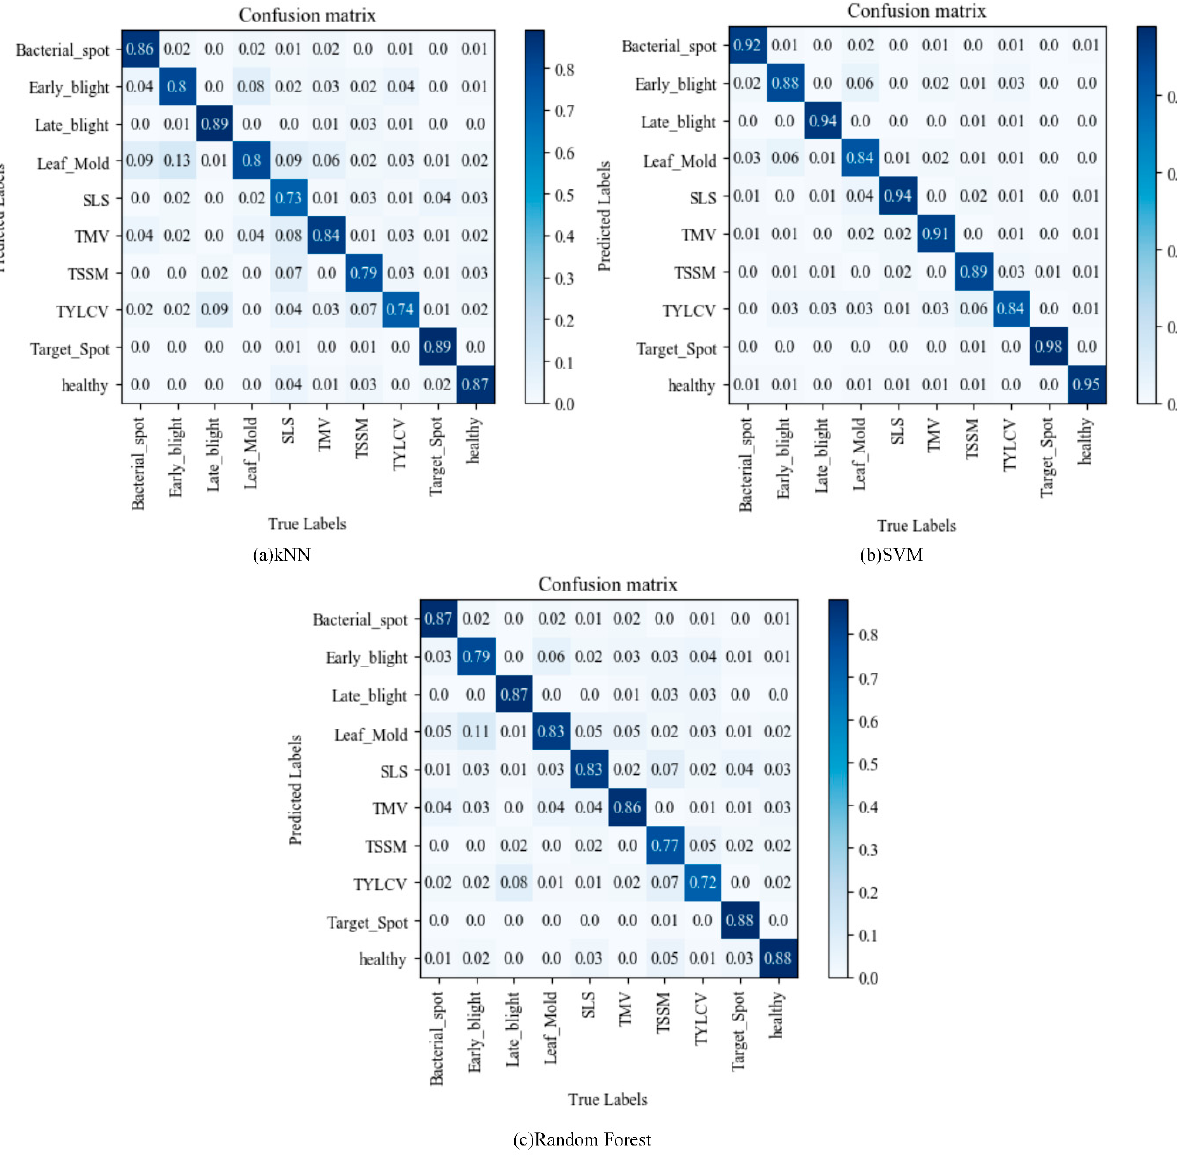
Figure 7. Confusion matrixes for the ( a ) kNN, ( b ) SVM, and ( c ) random forest algorithms.